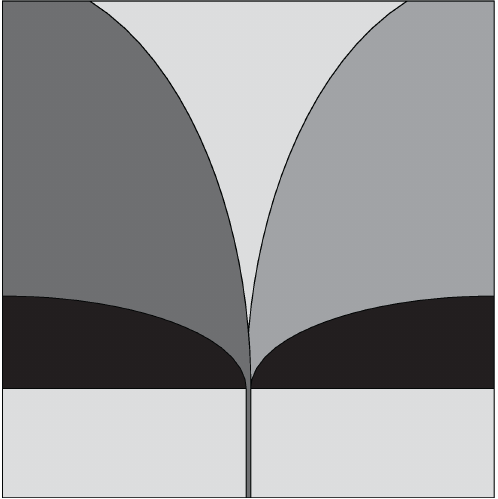
Figure 11. Resistive layer-based AVA for UWB microwave imaging systems (redrawn from [62]). Dark gray top metal face, medium gray bottom metal face, black resistive metal face, and light gray dielectric